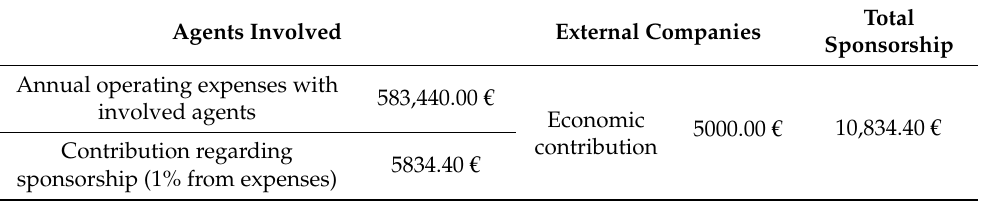
Table 12. Total annual income estimate from sponsors.